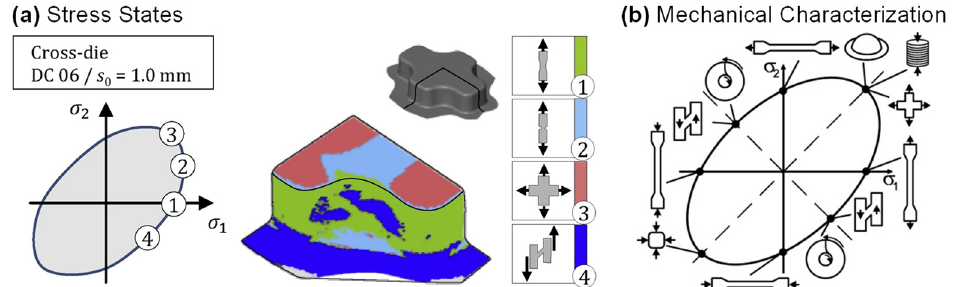
Figure 16. ( a ) Various stress states in deep drawing of a cross-cup. Reprinted from Ref. [240] with permission. Copyright 2018, Elsevier; ( b ) overview of testing methods for sheet metal characterization under different stress states. Reprinted from Ref. [241] with permission. Copyright 2014,